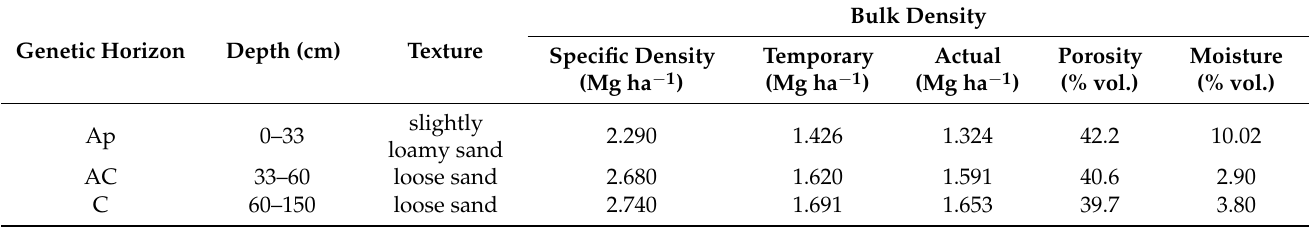
Table 1. Physical properties of the soil according to Rolbiecki et al.